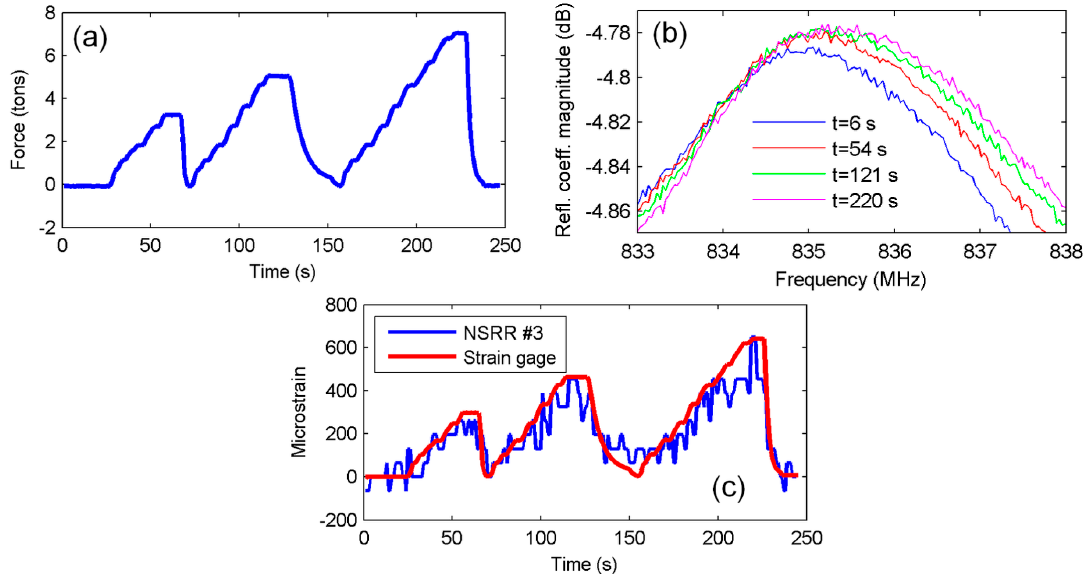
Figure 6. Elastic deformation region experiment results of NSRR #3: ( a ) applied vertical force read from the load cell; ( b ) NSRR #3 resonance frequency peaks with strain forming due to applied load at several time instants; and ( c ) strain obtained from NSRR #3 plotted versus time, and compared to the data from the strain gages.